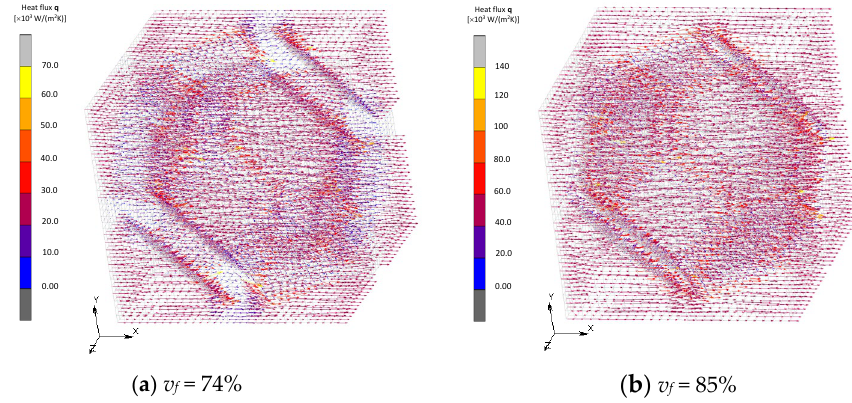
Figure 17. Heat flux field of Wigner–Seitz cell models.